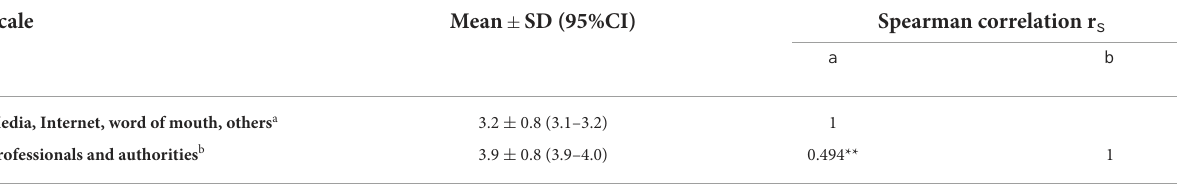
TABLE 4 Descriptive statistics (mean, standard deviation, and correlation coefficient) for each information source